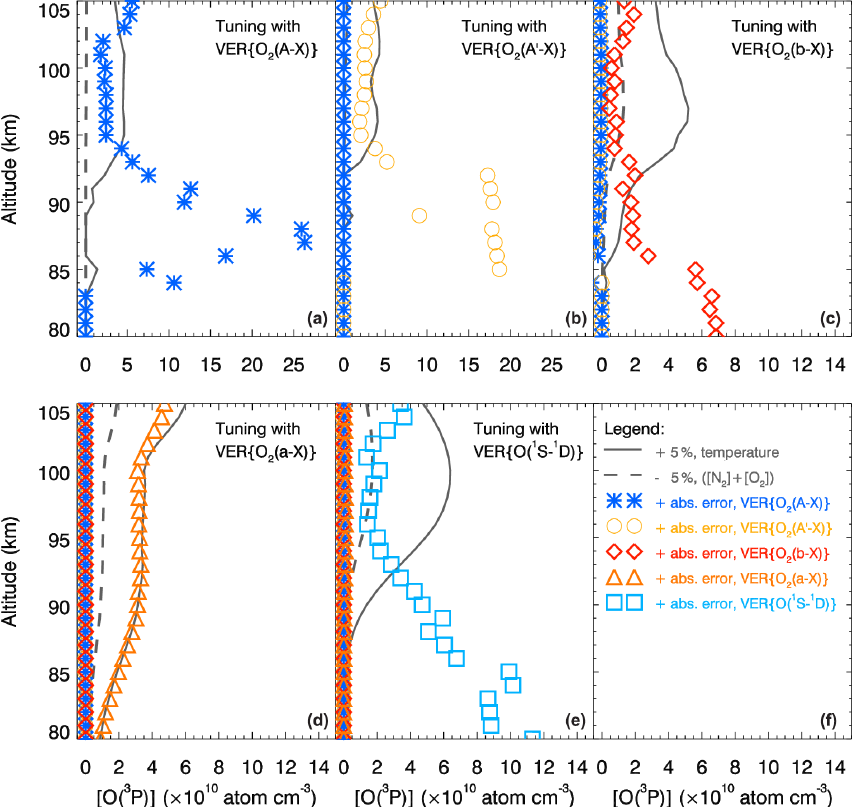
Figure 6. Effects of perturbations in the MAC input parameters on the retrieved [ O ( 3 P) ] profiles. The retrievals were performed at steps 2.1, 2.2, 2.3, 3.2 and 4.1 described in Table 12 on the basis of the following perturbed input parameters: volume emission rates (VERs), tem- perature ( T ), [N 2 ] and [O 2 ]. Additionally, [ O ( 3 P) ] profiles were retrieved on the basis of the unperturbed input parameters and denoted as reference [ O ( 3 P) ] profiles shown in Fig. 4. Finally, differences between the reference and perturbed [ O ( 3 P) ] profiles were estimated and are shown in five panels using the colors of the perturbed input parameters in the legend, which is shown in panel (f) . The units of the differences shown in panels (a) – (c) are the same as those of panels (d) – (f) . VER values were perturbed by values of the absolute error: + 20% for the VER { O 2 (a − X) } profile and + 10% for the other VER profiles. Data sets of T , [N 2 ] and [O 2 ] were obtained using the NRLMSISE-00 model and perturbed by 5%: + 5% for the T values and − 5% for the sum of the [N 2 ] and [O 2 ] values. Profiles of [ O ( 3 P) ] differences determined by perturbing VER profiles are shown by colored symbols, those determined by perturbing T profiles by solid gray lines, and those determined by perturbing ( [ N 2 ]+[ O 2 ] ) profiles by dashed gray lines. Each retrieval step is indicated by the name of the corresponding in situ ETON VER profile shown in the upper right corner of each